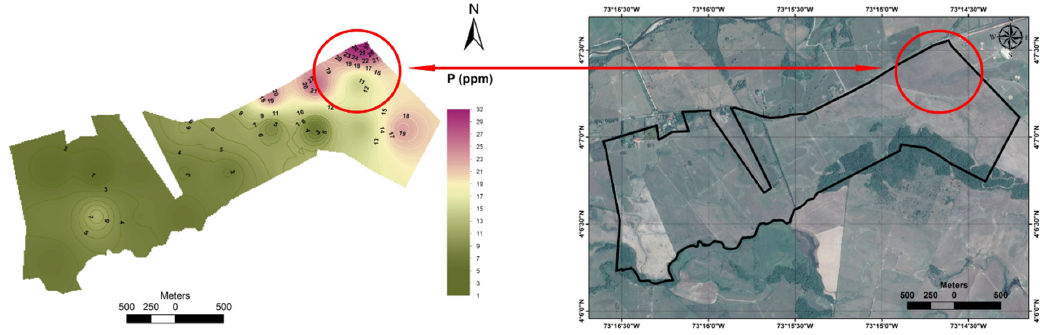
Figure 3. Distribution of phosphorus (P) in in the 0–30 cm depth interval ( left ), satellite image of the study area from Google Earth ( right ).